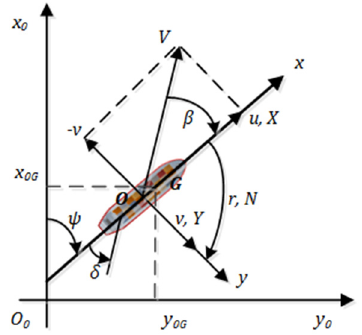
Figure 2. Definitions of ship motions.